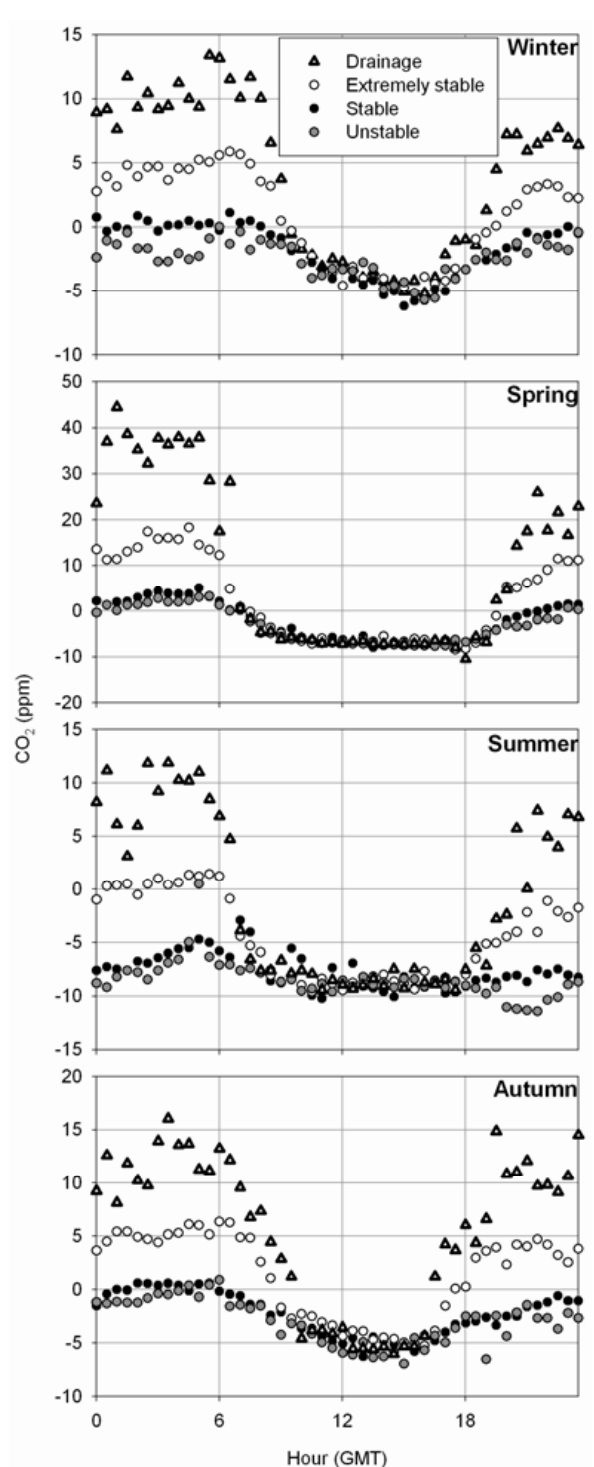
Fig. 8. Half-hourly medians of CO 2 concentrations calculated for the stability classes proposed during the four seasons of the year (from 1 August 2002 to 31 July 2005). Interquartile range was about 5ppm during the day and similar to the higher concentrations during the night.